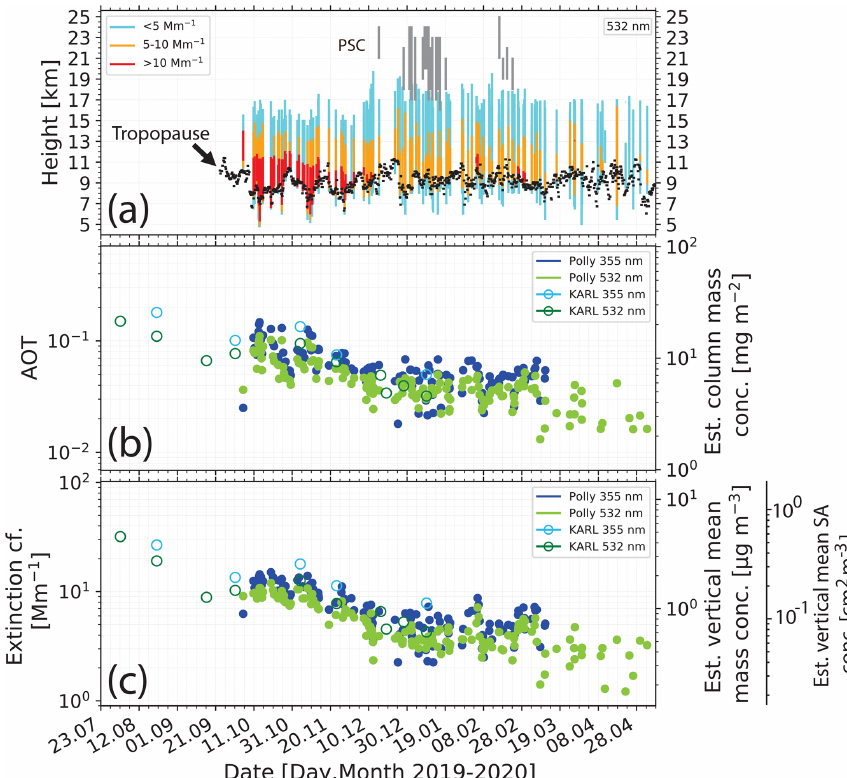
Figure 13. (a) Overview of Polly observations of UTLS smoke layers (coloured bars from bottom to top; one bar per day) from 23 July 2019 to 8 May 2020. Observational gaps between bars are caused by opaque low level clouds and fog. The colours in each bar indicate segments with different extinction coefficient levels ( < 5, 5–10, and > 10Mm − 1 ; see the legend in the panel). Furthermore, the tropopause is indicated as small black bars, and PSCs layers are shown as grey vertical lines. (b) Smoke layer AOT (KARL – open symbols; Polly – closed symbols) at 355 and 532nm, calculated from the profiles of the backscatter coefficients multiplied by a lidar ratio of 55 and 85sr, respectively. Column mass concentrations are indicated as well (right y axis). (c) Layer mean 355 and 532nm particle extinction coefficient (i.e. AOT in panel b divided by layer depth in panel a ) and respective estimated mass and surface area concentrations (right y axis). For comparison, background AOT and extinction levels (532nm) are of the order of 0.001–0.002 and 0.1–0.2Mm − 1 , respectively (Baars et al.,